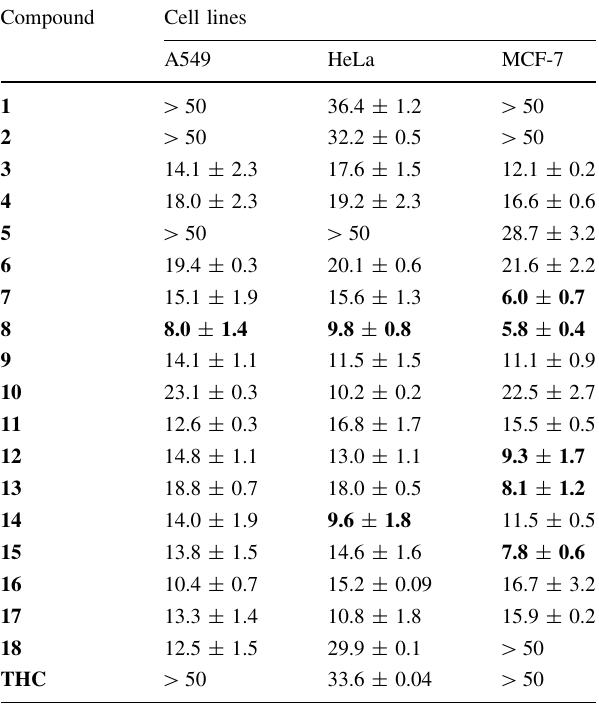
Table 1 In vitro cell proliferation-inhibitory activity of the synthe- sized compounds (IC 50 , l M) a